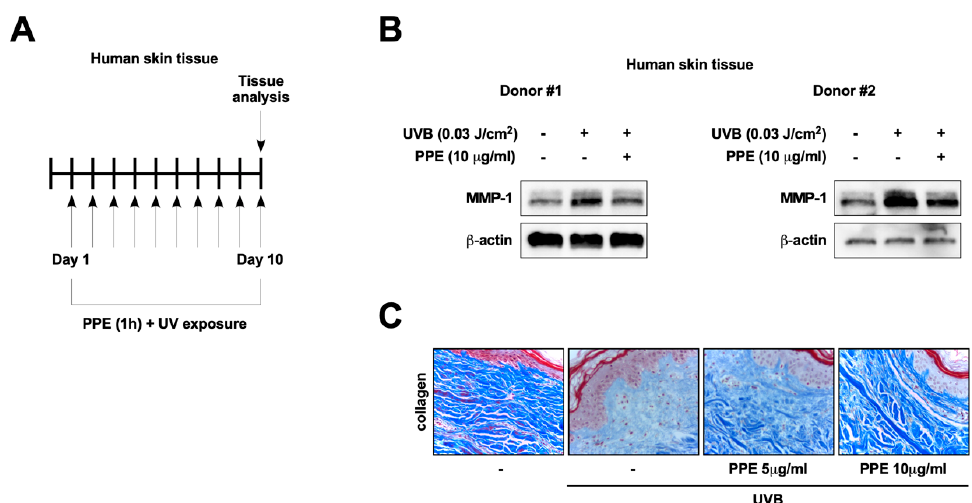
Figure 2. Propolis extract prevents UV-induced matrix metalloproteinase (MMP)-1 expression and collagen degradation in human skin tissues. ( A ) Human skin tissues from two donors were treated with propolis extracts (PPE) and exposed to UVB for 10 consecutive days. At the end of the study, the tissues were fixed in formalin or lysed with lysis buffer for protein extraction; ( B ) MMP-1 expression in human skin tissue lysates was assessed by immunoblotting; ( C ) Collagen fibers were detected with Masson’s trichrome staining.